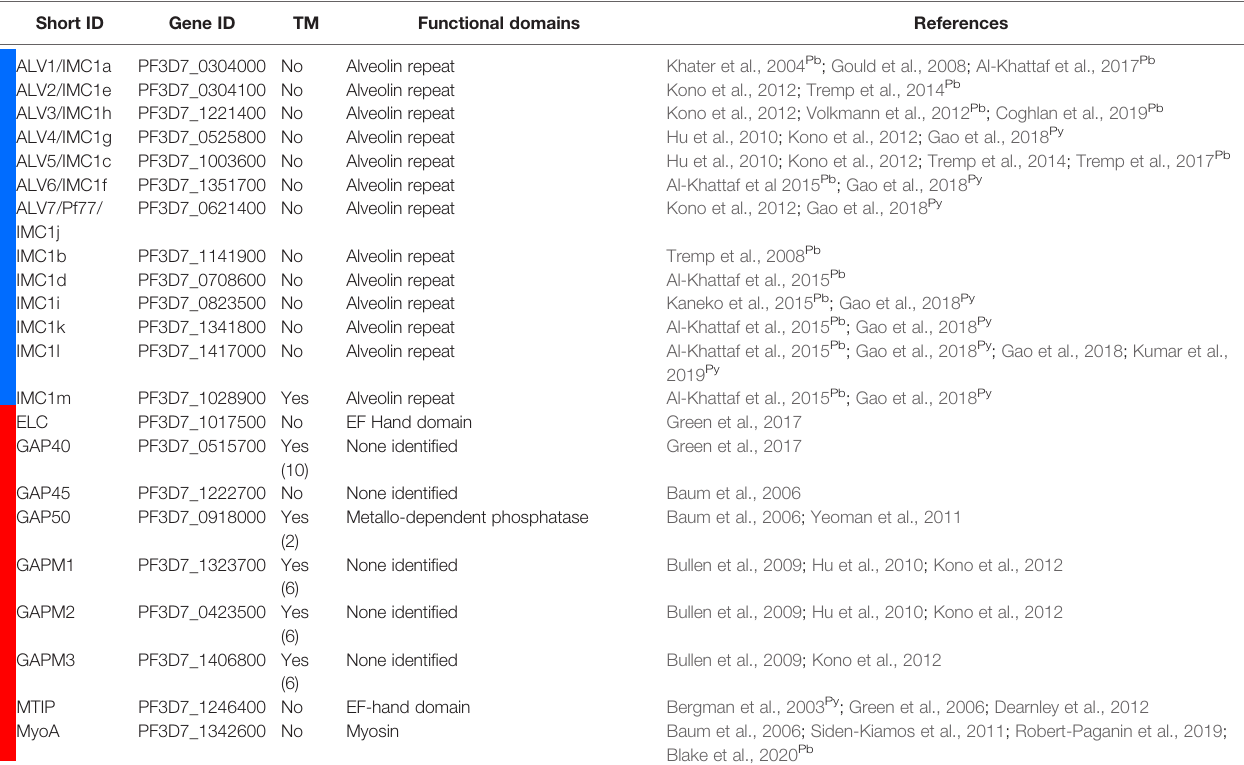
TABLE 1 | Plasmodium spp. IMC proteins and other apicomplexan IMC proteins with P. falciparum